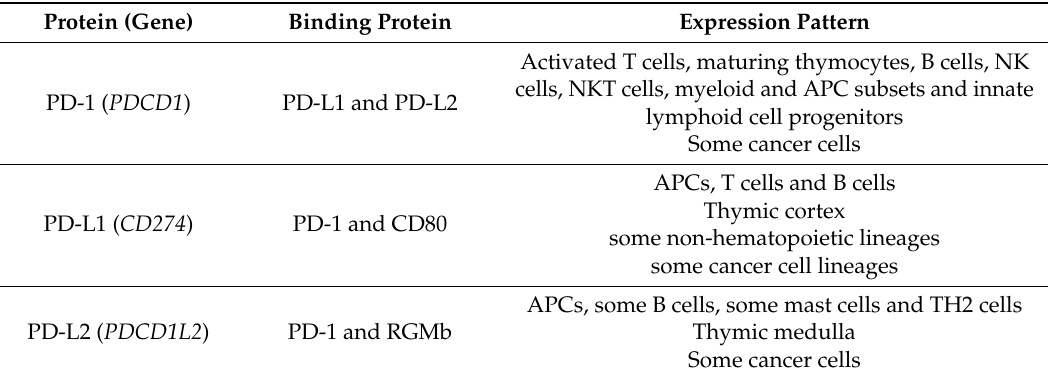
Table 1. Expression pattern of PD-1 and its ligands. Adapted from [43,45]. Protein